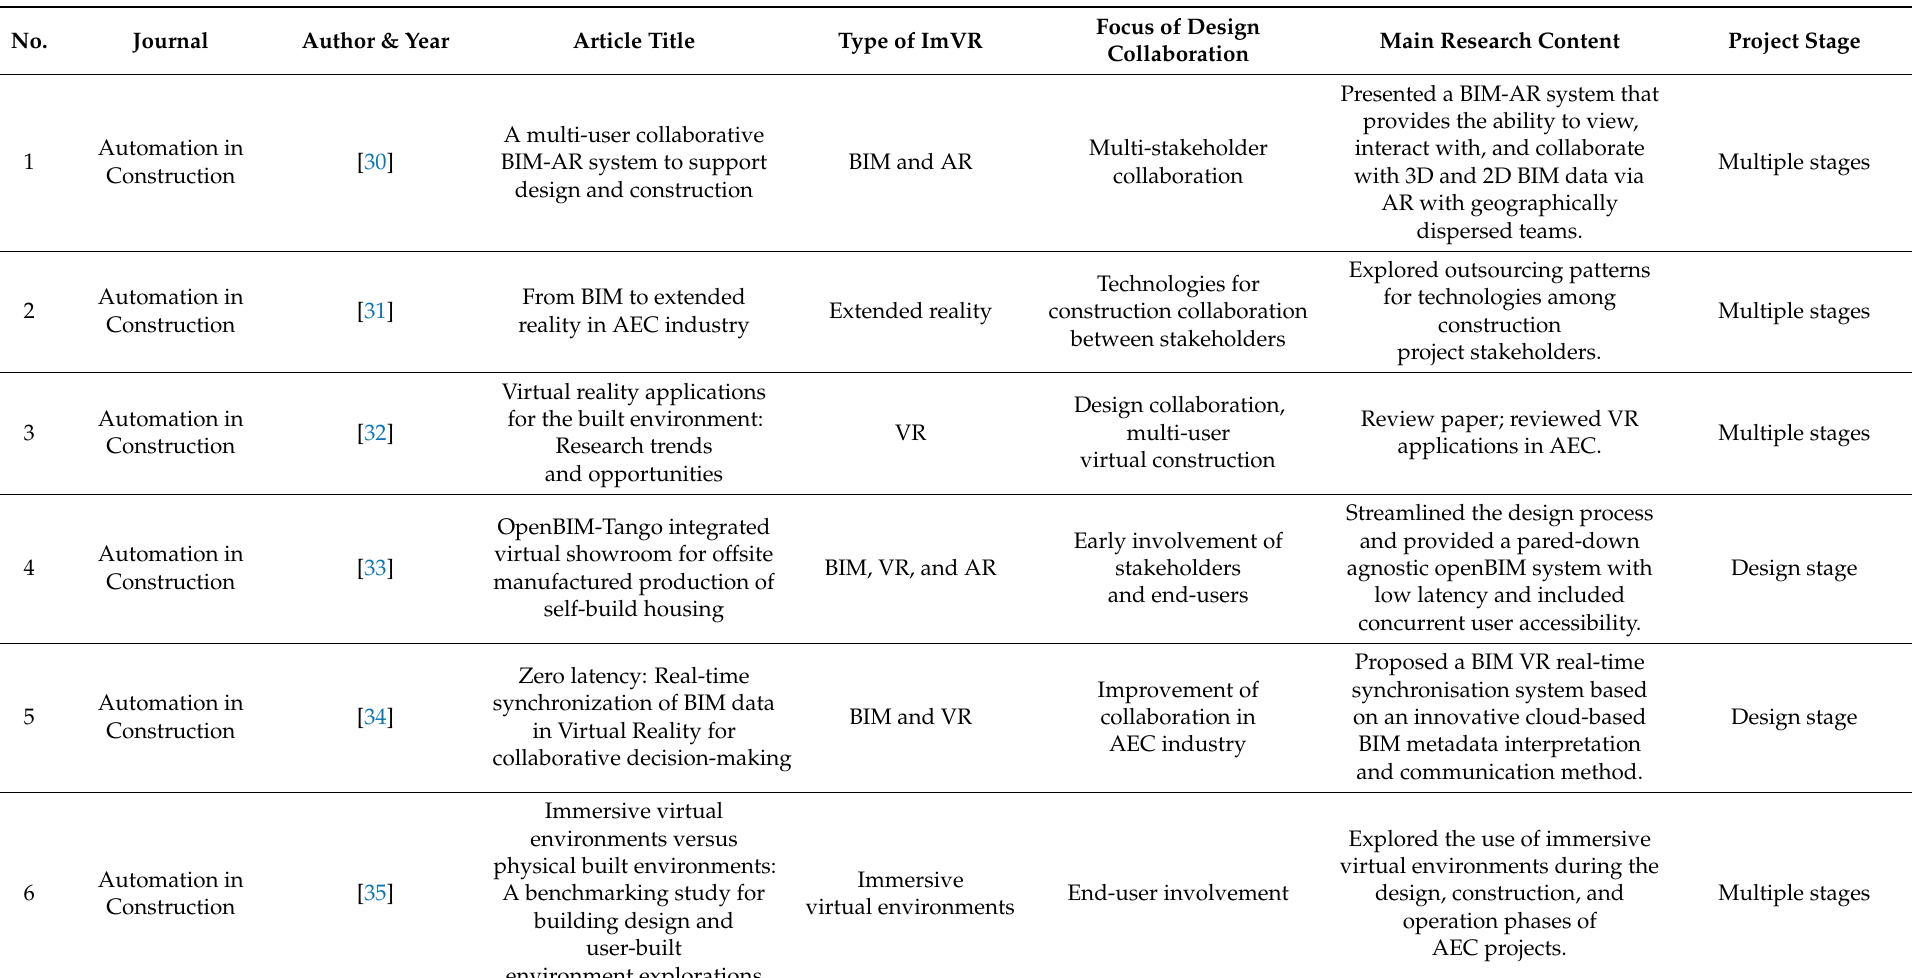
Table 1. Reviewed articles on design collaboration in